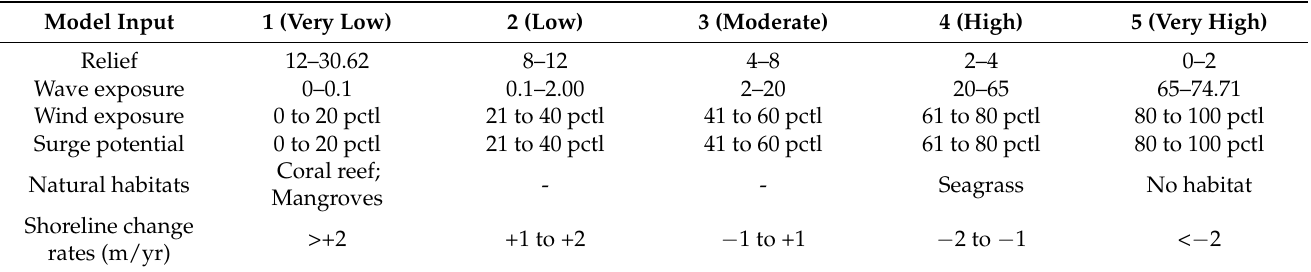
Table 1. Ranking and classification of indicators used.